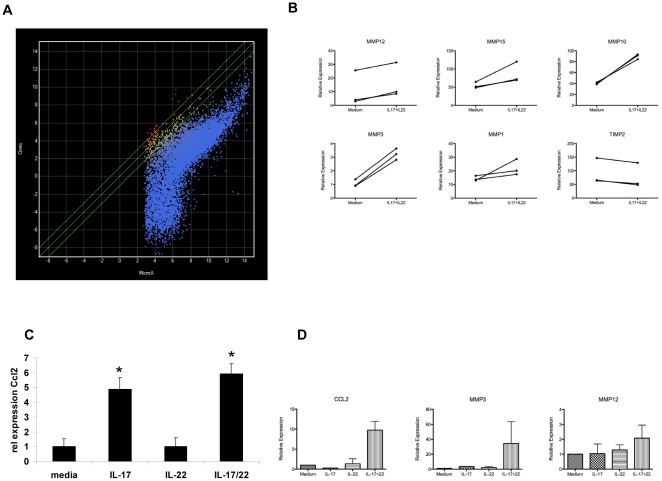
Th17 cytokines induce MMP expression in HBE cells.(A) Primary HBE cells were stimulated with media or a combination of 10/-50 ng/ml IL-22 and 50 ng/ml of IL-17A for 48 hours (n = 3 donors per condition). RNA was harvested and subjected to hybridization on Hu-133 arrays for RNA sequencing as described in the Methods. Transcript abundance or hybridization intensity was measured on normalized data in Qseq software (Lasergene). Scatter plot analysis of normalized transcript abundance for Affymetrix (x-axis) and RNA-seq (y-axis) are shown. (B) Relative gene expression of MMPs and TIMP2 from RNA-seq data. (C) Up-regulation of Ccl2 by IL-17 and IL-22 combination treatment in primary HBE cells as measured by RNAseq. (D) CCL2, MMP3 and MMP12 gene expression were analyzed by real-time RT-PCR.